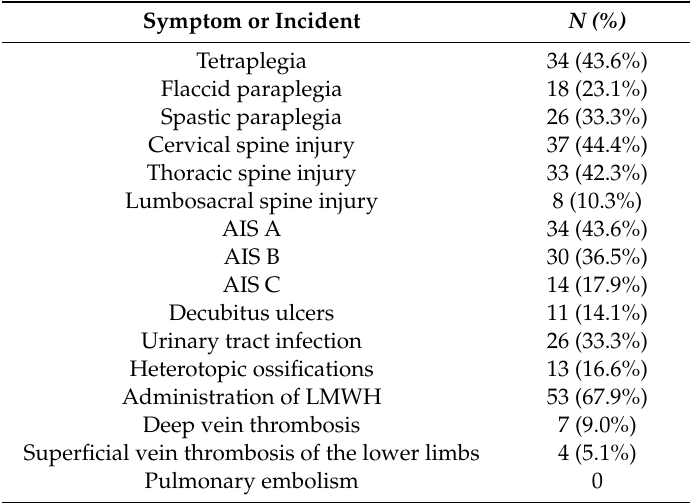
Table 1. Study group characteristics: number of patients ( N ) with specific